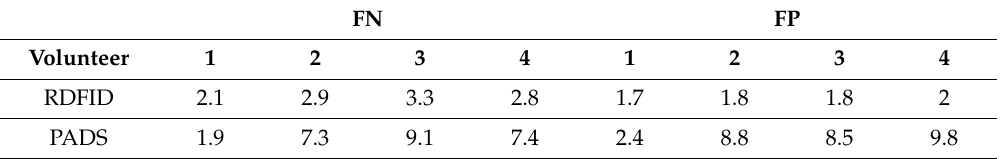
Table 3. FN/FP of human detection of different people (%).